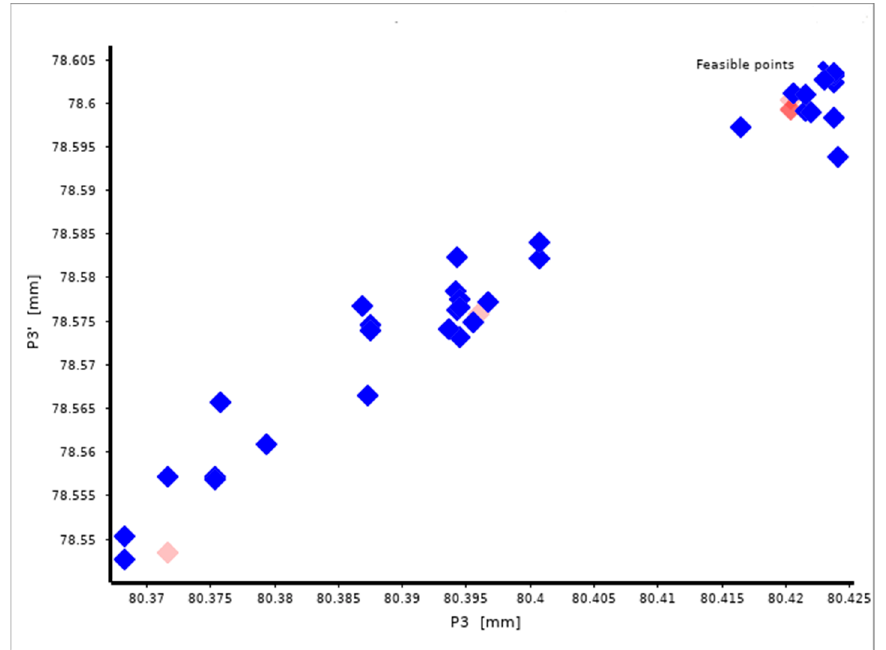
Figure 11. Trade off chart for the P3 parameter. Red points present the worst cases, while the blue points are the best ‐ chosen results.